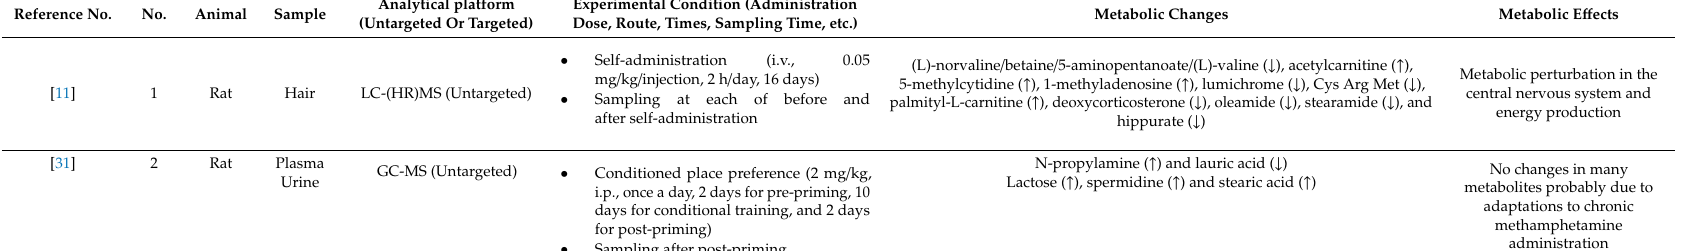
Table 2. Summary of significantly metabolites changes following methamphetamine exposure in other samples Reference No.